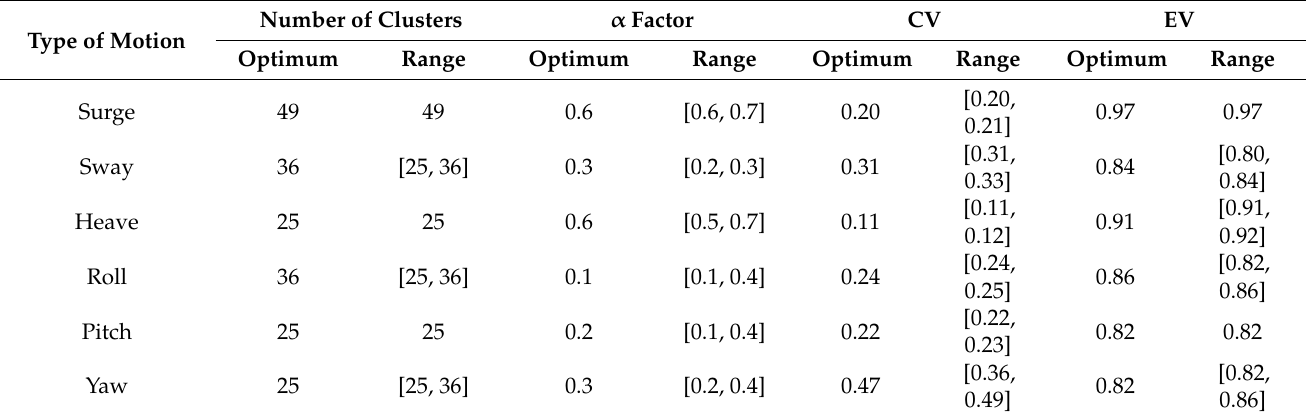
Table 3. Practical criteria to define the values for “number of clusters” and “ α ” in the application of the methodology. Validity ranges are determined by CV and